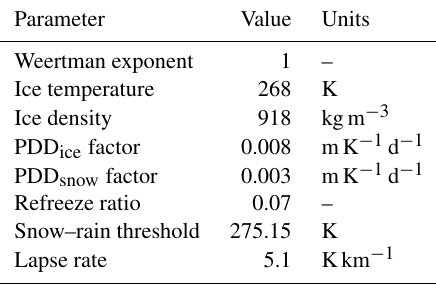
Table 1. Key model variables and